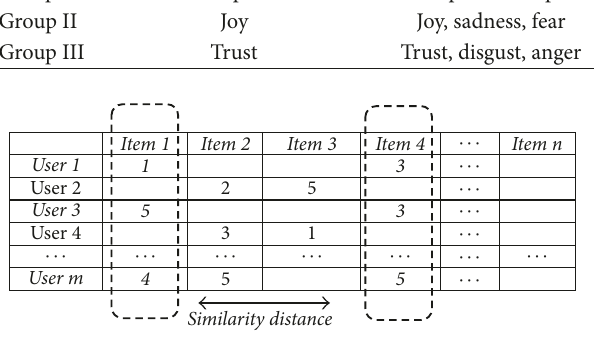
Figure 6: User-item